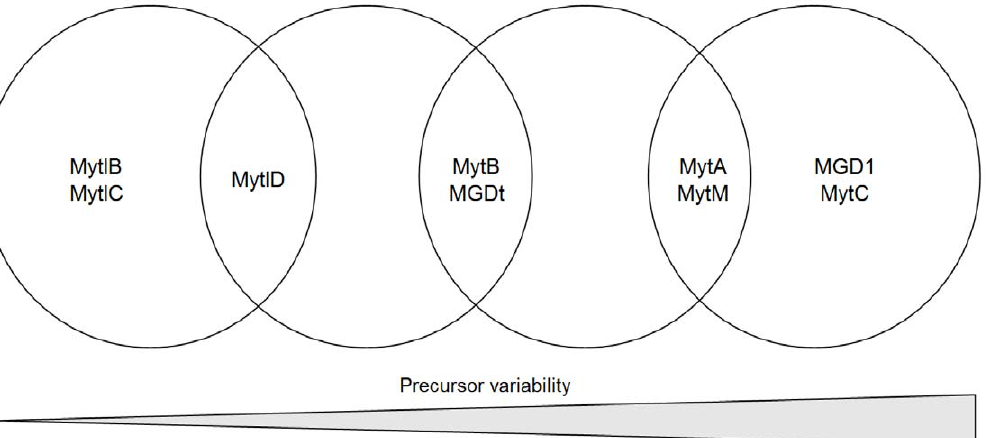
Figure 2. AMP precursors grouped on the basis of their variability. Grouping based on HSD test, a =0.05; sample-specific and averaged diversity levels are reported in Table